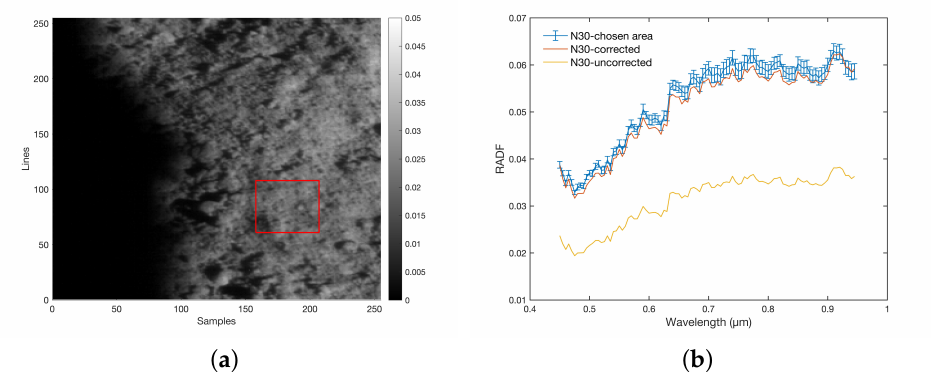
Figure 8. Comparison of reflectance after shadow correction and normal area reflectance. ( a ) Radiance image at 750 nm; the red rectangle marks the area in which the normal lunar soil is not obscured by shadows. ( b ) We randomly chose 100 pixels of the normal areas marked in ( a ) five times. The blue curve shows the mean reflectance factor (RADF) curve of them and their standard deviation; the reflectance is significantly enhanced after shadow